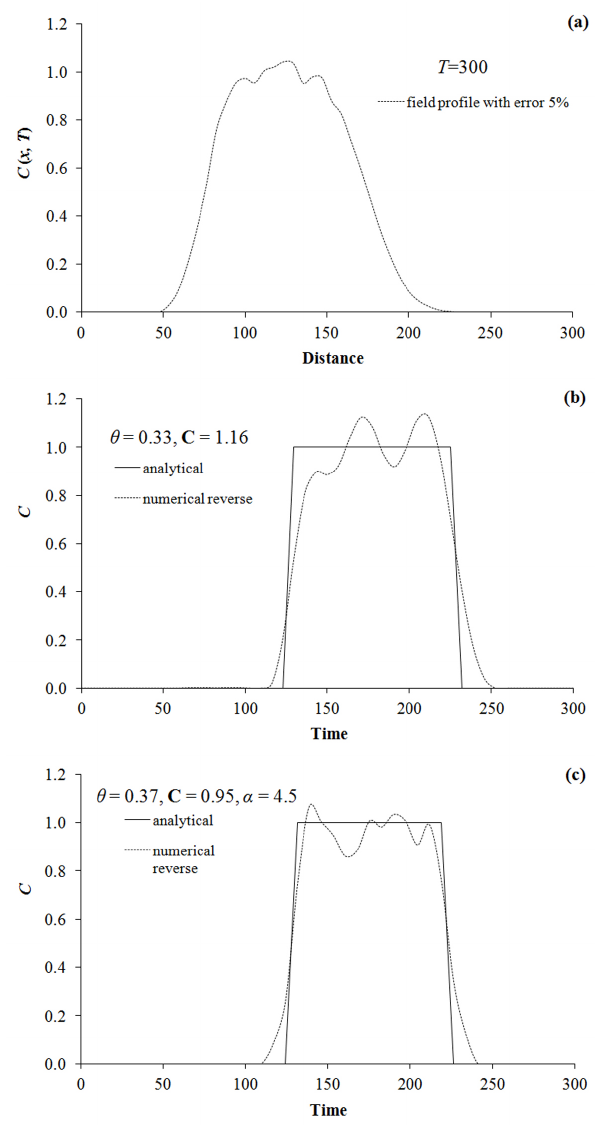
Fig. 9. Reverse routing of a concentration profile seeded with 5% multiplicative random error: (a) error-contaminated field data at time t = T = 300; (b) recovered square pulse by reverse-routing to the source, with low-pass filtering; (c) recovered square pulse by reverse-routing to the source, with optimisation.